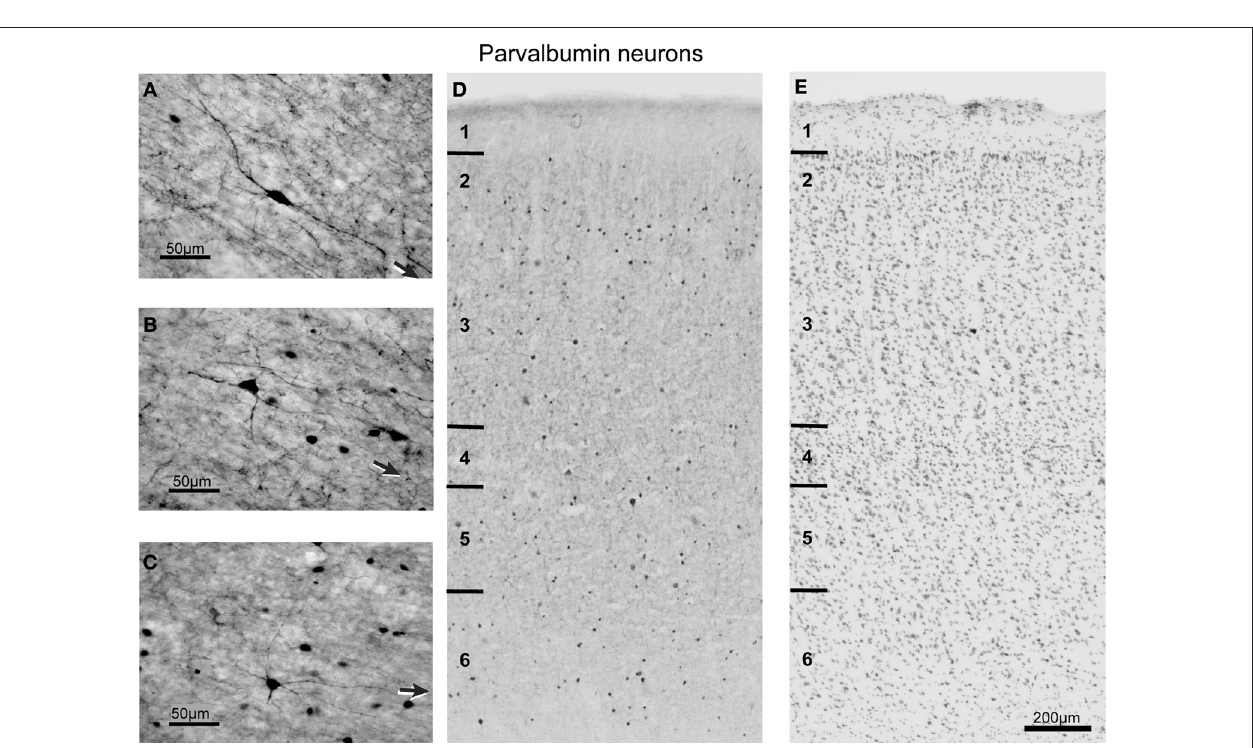
FIGURE 5 | Brightfi eld photomicrograph of CB-labeled neurons in FEF. Most of these neurons are present in layers 2 and 3. Conventions as in Figure 4 .